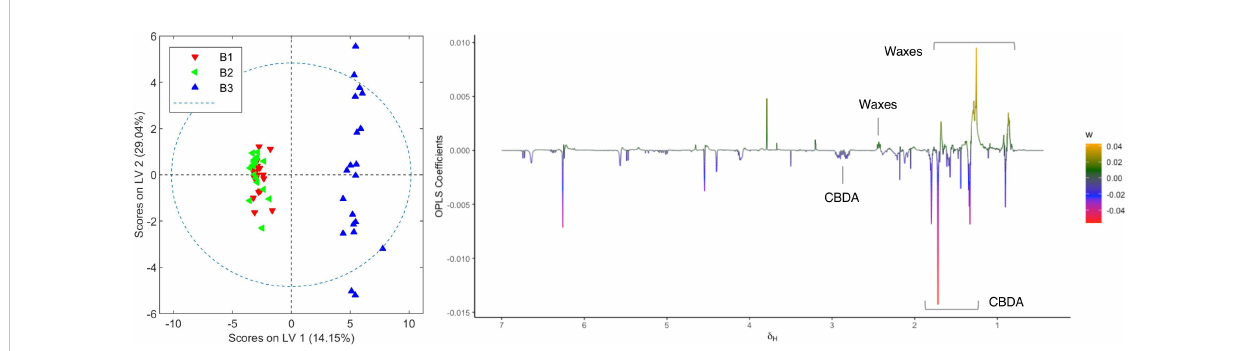
FIGURE 5 Score and loading factor plots obtained from the OPLS-DA between organic extracts of healthy and infected crops of chemovar B. The metabolites that differentiate the two groups are annotated in the loading factor plots. The R 2 Y and Q 2 Y coef fi cients for the model were 0.98 and 0.91, respectively, and the ROC curve had an AUC value of 1.00 (see Figures S13, S14).